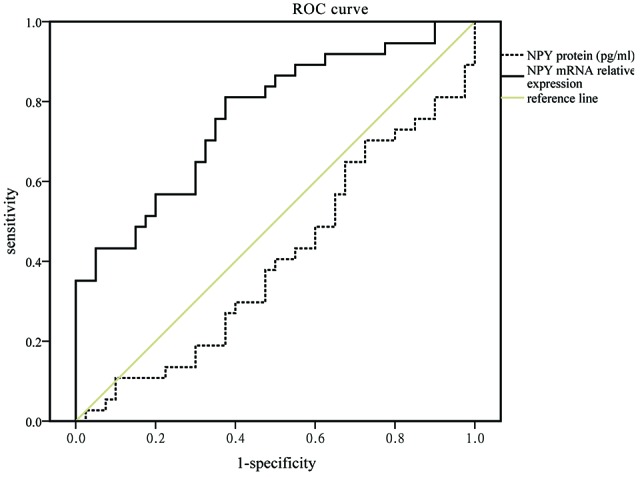
Receiver operating characteristic (ROC) curve for mRNA expression and serum concentration of neuropeptide Y (NPY) which areas under the line were 0.766 (95% CI, 0.656–0.876, P < 0.001, solid black line) and 0.407 (95% CI, 0.275–0.540, P = 0.176, dotted black line), respectively.